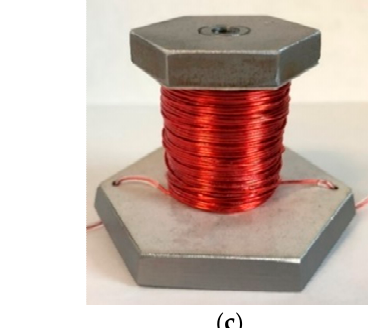
Table 1. Optimized stator pole dimensions (mm).